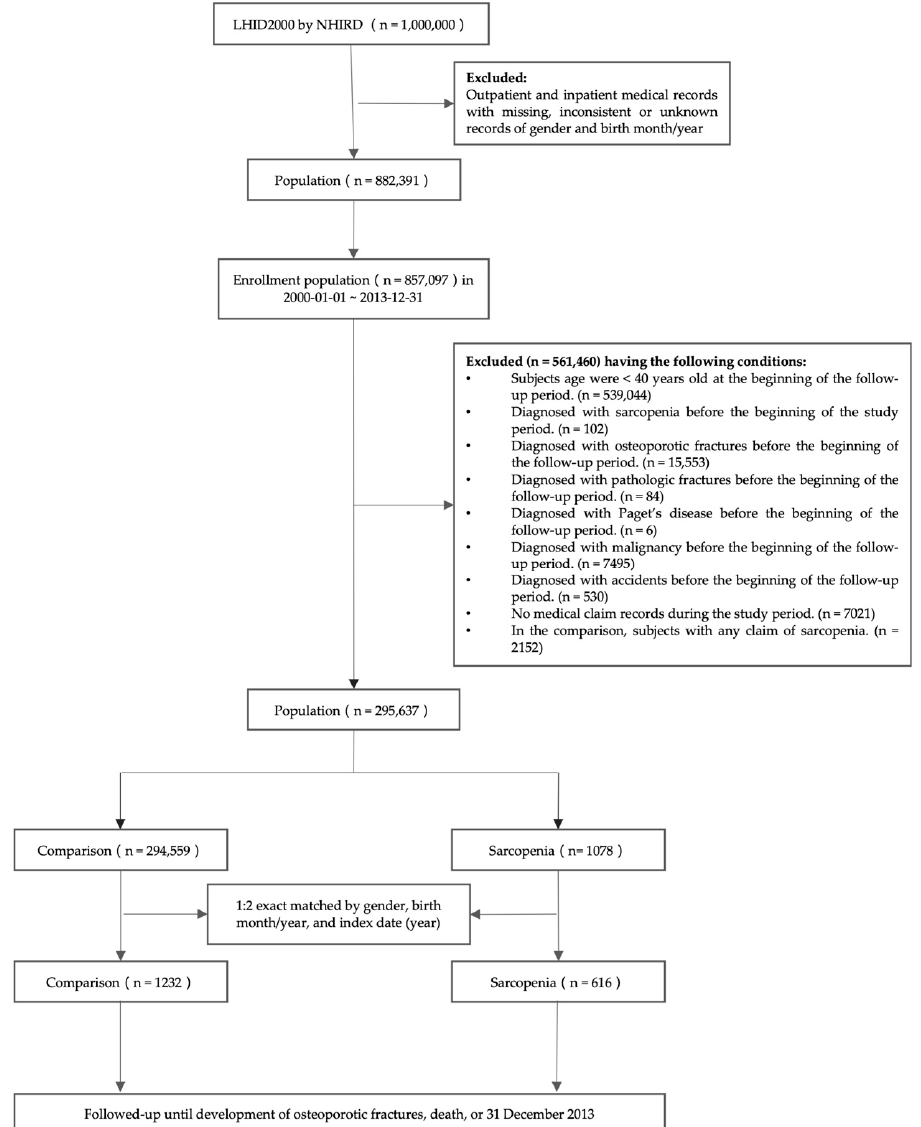
Figure 1. Flow chart of the study population selection.